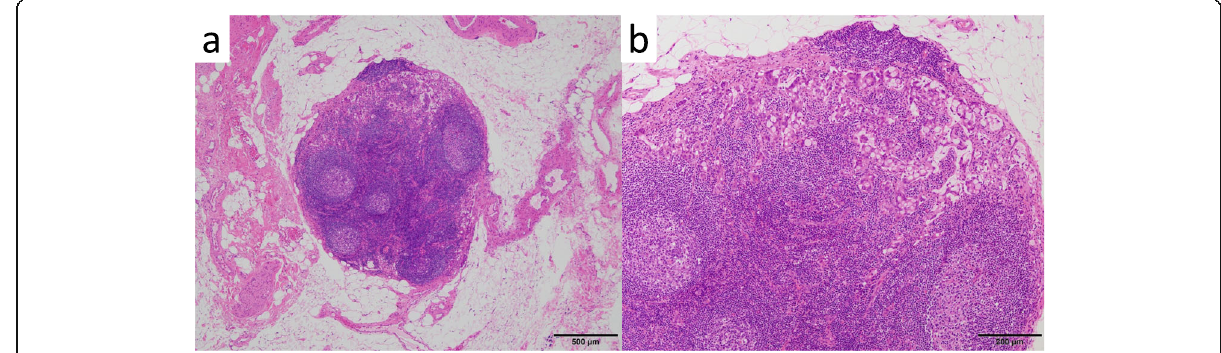
Fig. 4 Histopathological findings. Lymph node metastases from the primary lesion. a × 40 and b × 100 magnification